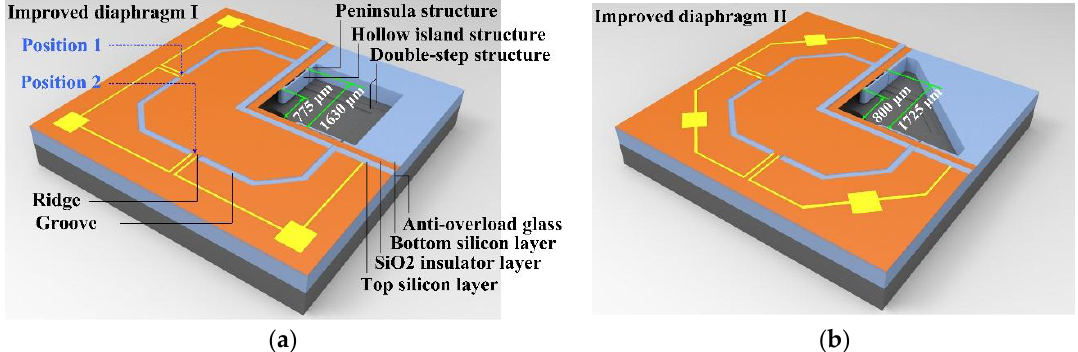
Figure 16. Schematics of the peninsula-island based bossed diaphragm structure: ( a ) improved diaphragm I with peninsula-island structure along the side edge direction; ( b ) improved diaphragm II with peninsula-island structure along the diagonal direction.